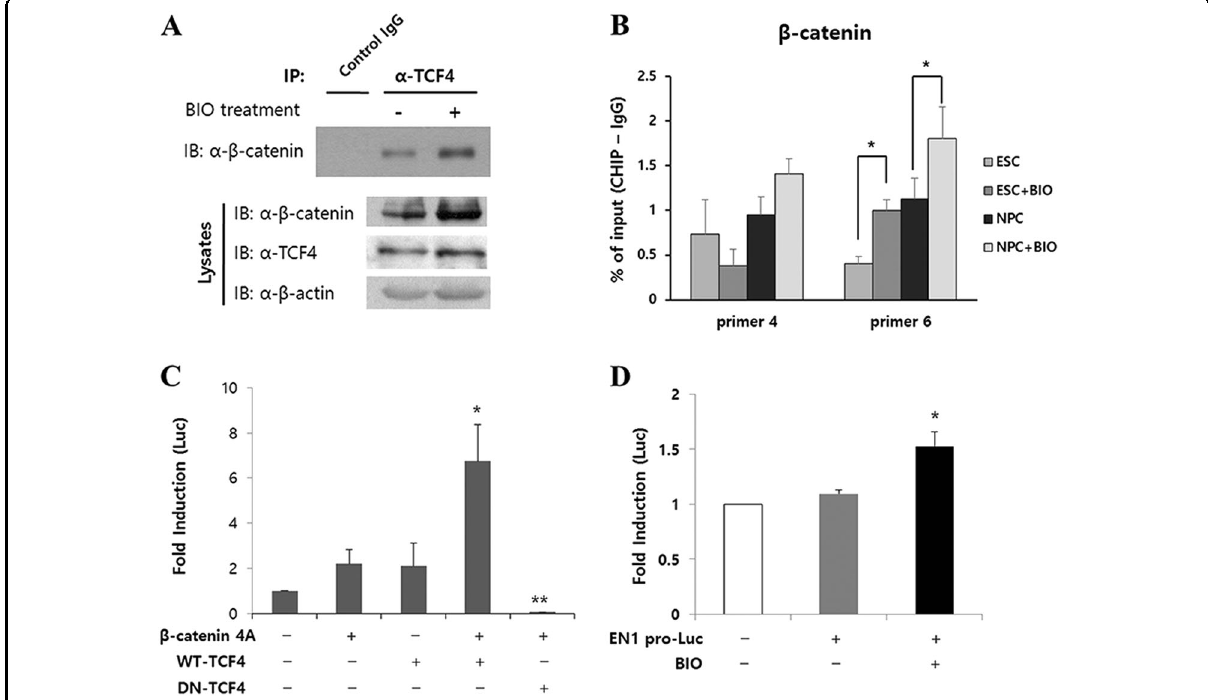
Fig. 2 EN1 expression is regulated by the β -catenin/TCF complex through direct binding to the EN1 promoter region. a Co-IP analysis showed that the interaction between β -catenin and TCF4 increased by BIO-treatment. b , c ChIP assays for β -catenin/TCF4 complex to the putative binding motif of EN1 promoter. The y -axis represents the means ± S.E.M. of the relative binding level of β -catenin (via TCF4) to each target sequence. c Expression of luciferase driven by a 5-kb-long regulatory region of human EN1 gene in HEK 293 cells. A reporter gene was strongly induced by over- expression of both constitutively active mutant of β -catenin (Cat4A) and WT-TCF4. d BIO treatment directly increased luciferase expression under the control of the EN1 regulatory sequence in human ESC-derived NPCs. Statistical signi fi cance was estimated using one-way ANOVA with multiple comparisons among groups from at least three independent experiments; * p < 0.05, ** p <